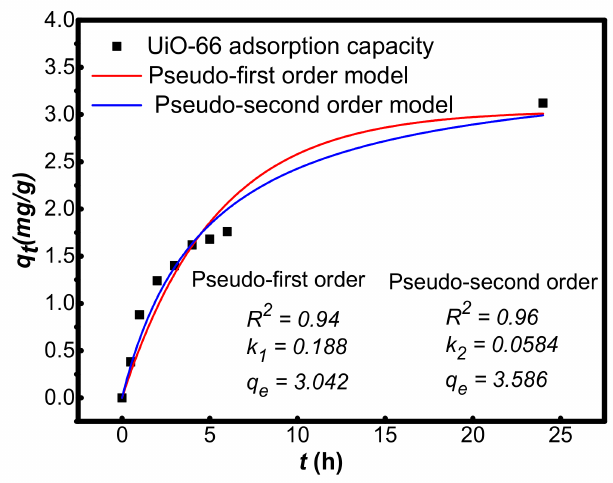
Figure 2. SEM of UiO-66 ( a ), UiO-66 after soaking in acid solution of pH = 1 for 12 h ( b ) and UiO-66 after soaking in acid solution of pH = 2 for 12 h ( c ).